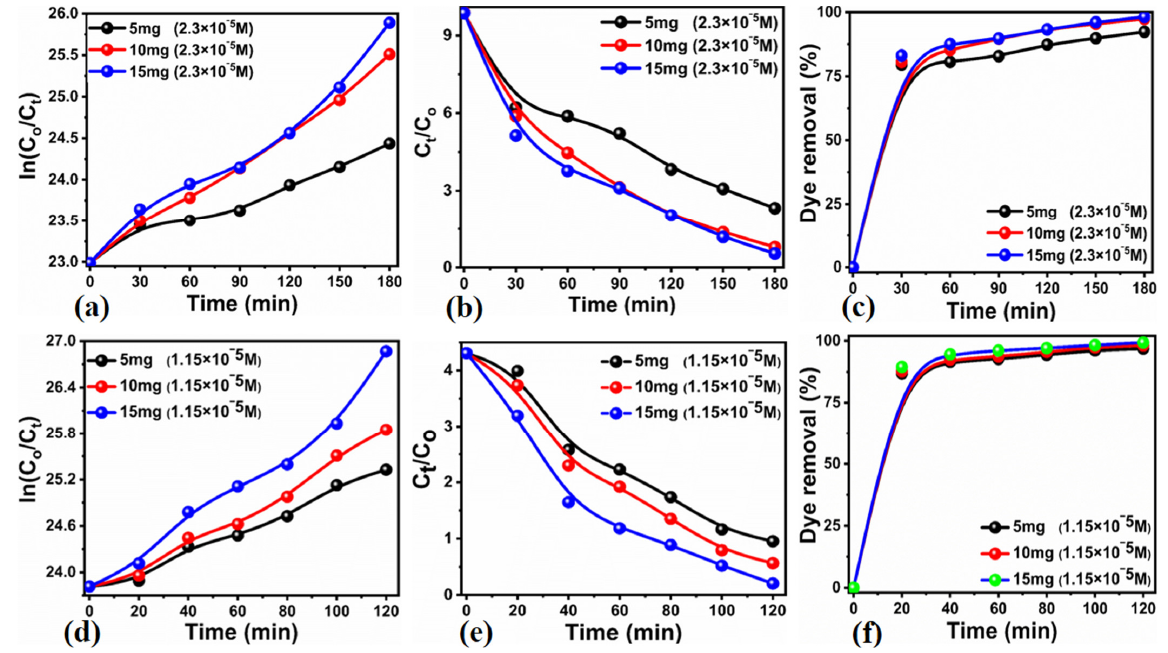
Figure 5. Degradation kinetics of MB using different catalyst doses of 5, 10 and 15 mg in 2.3 × 10 −5 M MB solution under the irradiation of UV light. ( a ) Linear plot of the natural logarithm of concentrations Ln(C t /C o ) against time for 180 min. ( b ) Corresponding linear plot of C t /C o ( c ) corresponding degradation efficiency MB solution. ( d ) Degradation kinetics of MB in 1.15 × 10 −5 M MB with a corresponding linear plot of the natural logarithm of concentrations Ln(C t /C o ) against time for 120 min. ( e ) Corresponding linear plot of C t /C o in 1.15 × 10 − 5 M MB ( f ) corresponding to the degradation efficiency of 1.15 × 10 − 5 M MB